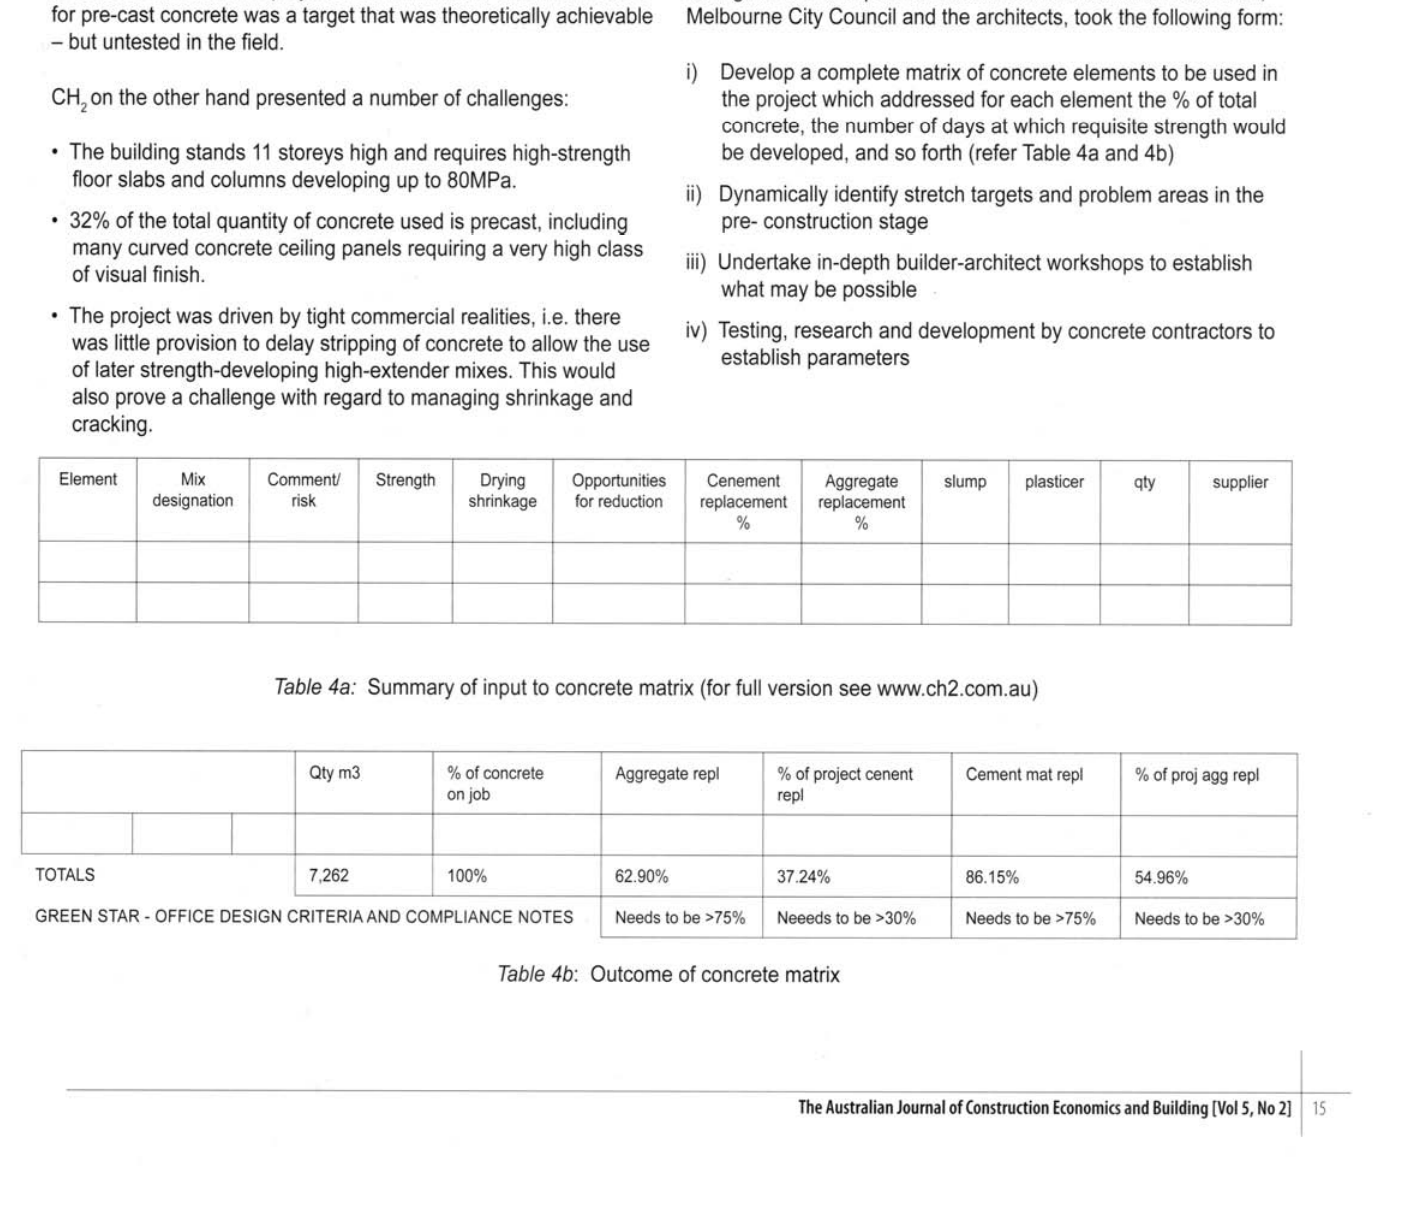
Table 4b: Outcome of concrete